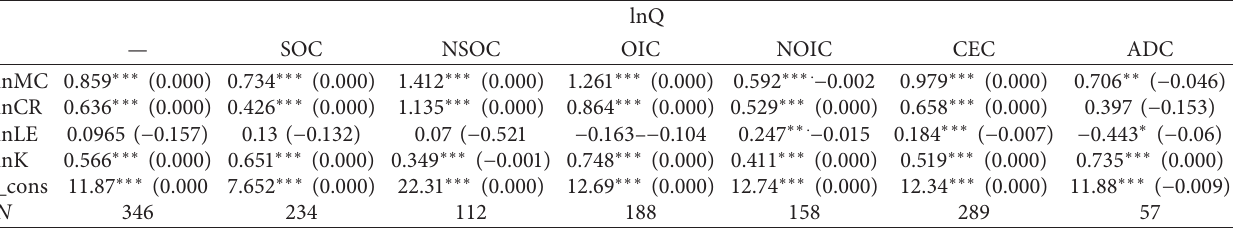
Table 3: Estimation results for profit